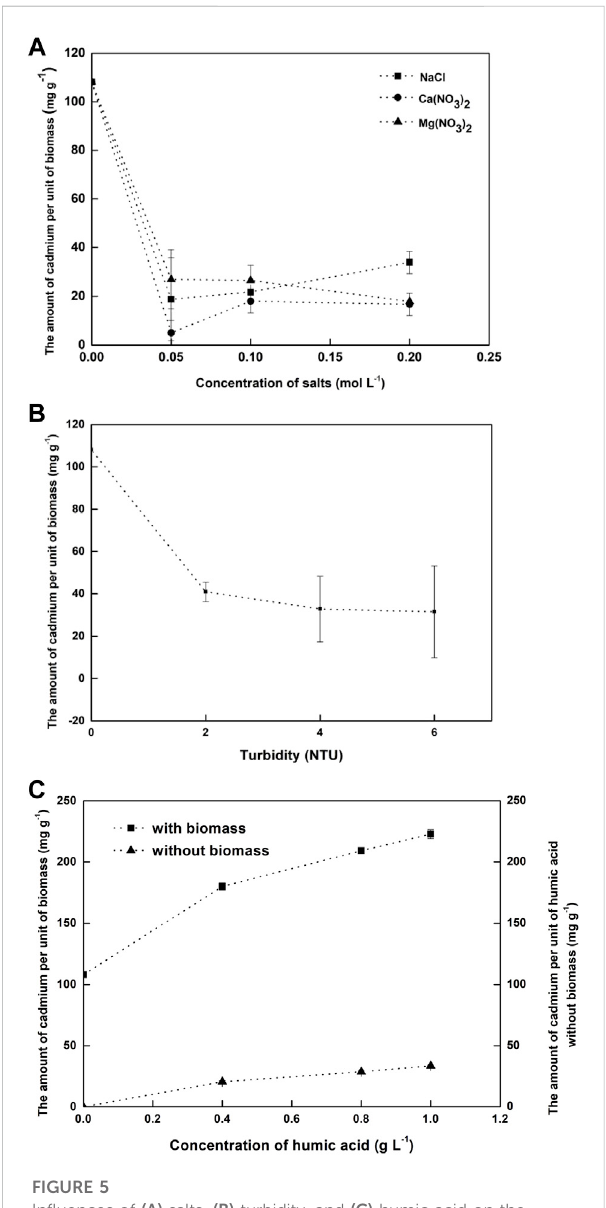
FIGURE 5 In fl uences of (A) salts, (B) turbidity, and (C) humic acid on the adsorption amount of Cd(II) by non-living Nitzschia